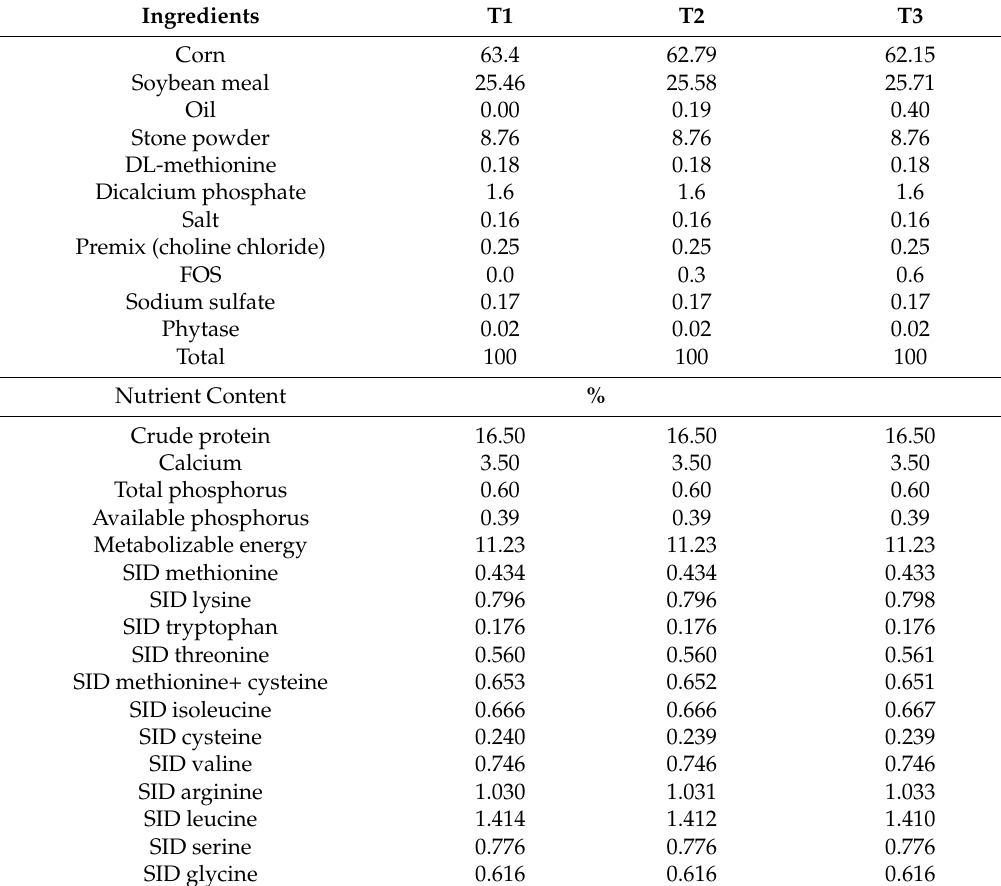
Table 1. The composition and nutrient levels of the basal and prebiotics-supplemented diets. Ingredients